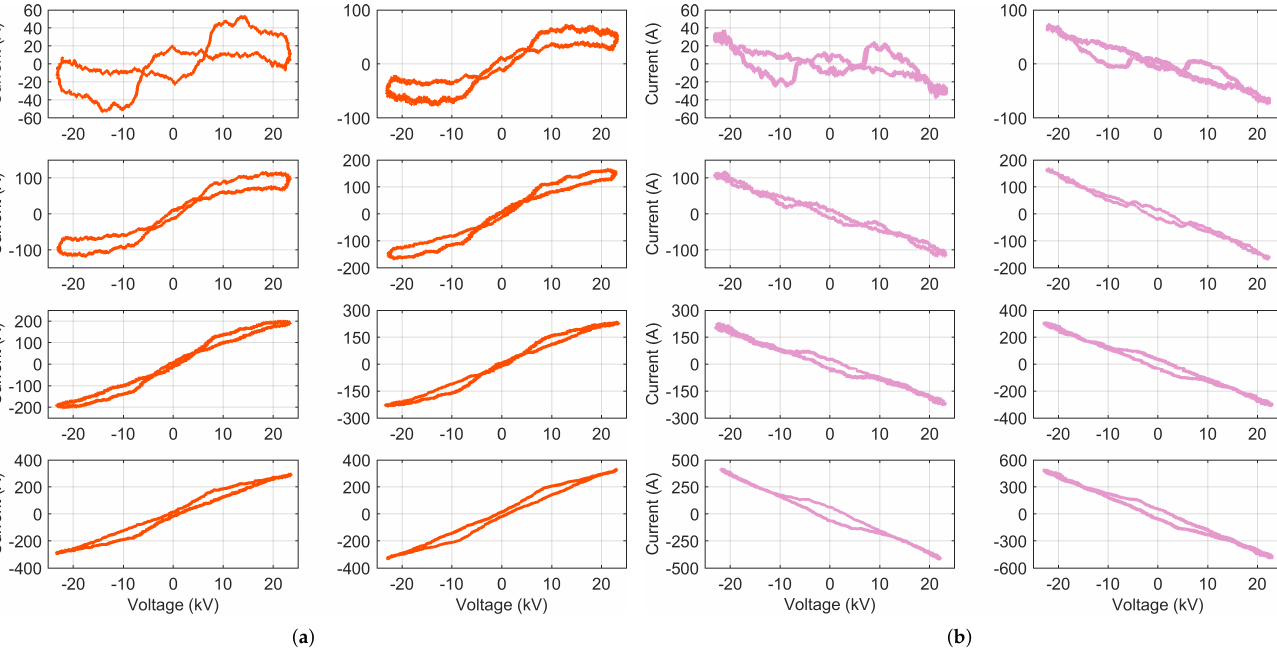
Figure 5. Typical VI trajectories for Germany (from low to high current intensities, top to